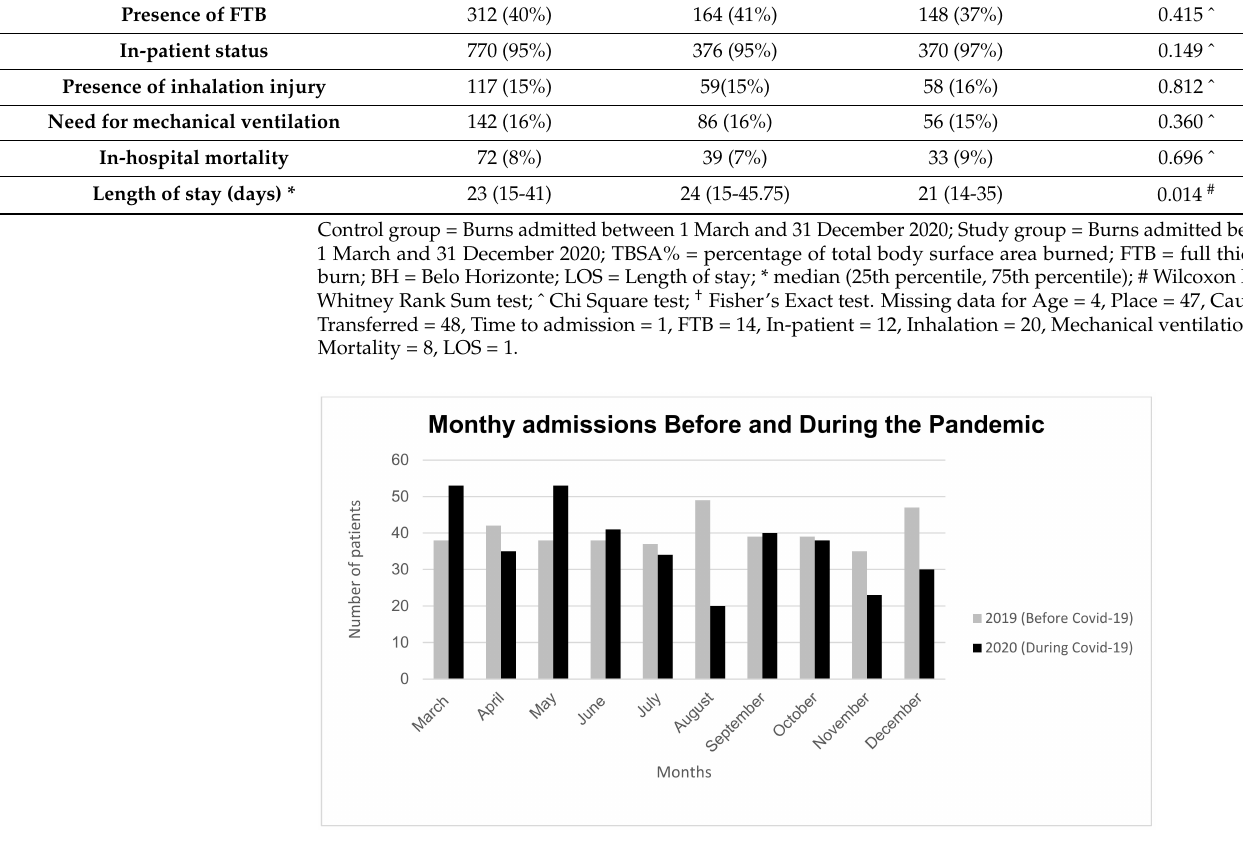
Figure 1. Monthly burn admission before and during COVID-19. Table 2. Differences between pediatric burn admissions before and during the COVID-19